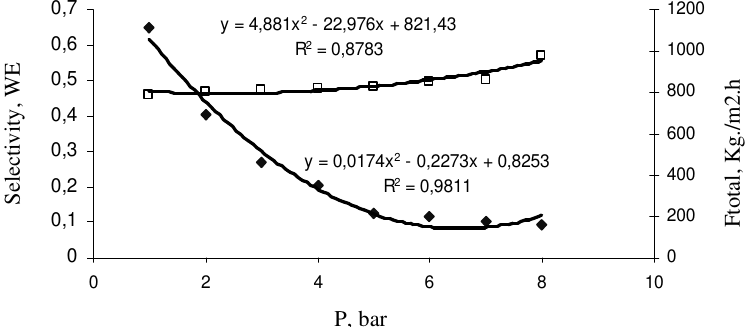
Figure 13. Evolution of total flow and selectivity with increasing feed pressure of the ethanol-water